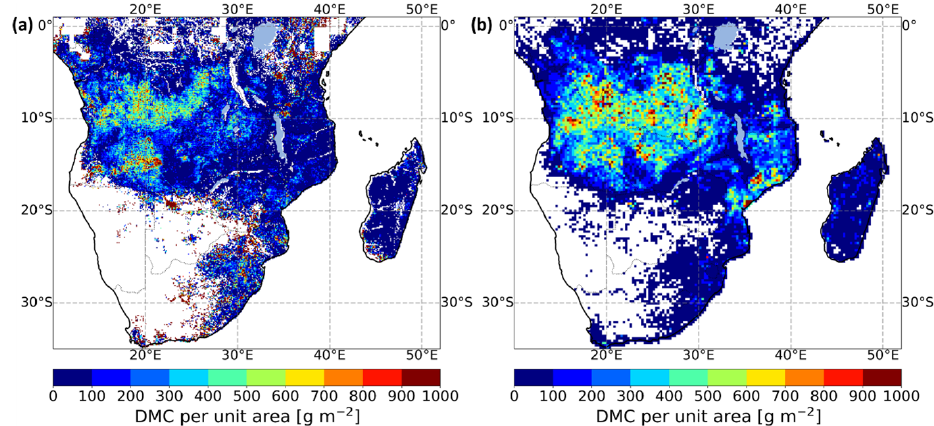
Figure 6. Dry matter consumed (DMC) per unit area, mapped across Southern Hemisphere Africa for 2019. (a) As calculated in 0.1 ◦ grid cell resolution by dividing the FREMs_bCO CO values (with SF correction) by the 20m FireCCISFD burned area product generated from Sentinel-2 MSI observations and (b) as reported in GFED4.1s at 0.25 ◦ grid cell resolution.